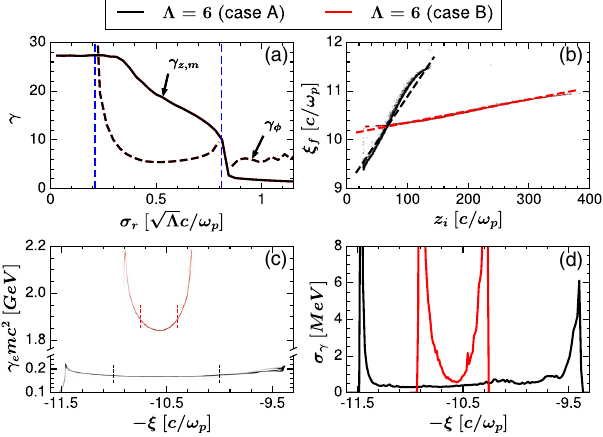
FIG. 3. (a) γ z;m (solid) and γ ϕ (dashed) calculated from Eq. (2) as a function of σ r for case A. The blue dashed lines enclose regions of injection where γ z;m > γ ϕ . (b) The phase space of injected electron charge in the ξ f − z i plane for case A (black) and case B (red). The dashed lines are calculated from Eq. (4). (c) The phase space γ − ξ and (d) slice energy spread σ γ of injected electrons at position z ¼ 260 ð 1630 Þ c= ω p for case A (B). The injected beams are subdivided into 128 (64) slices for cases A (B), respectively, in